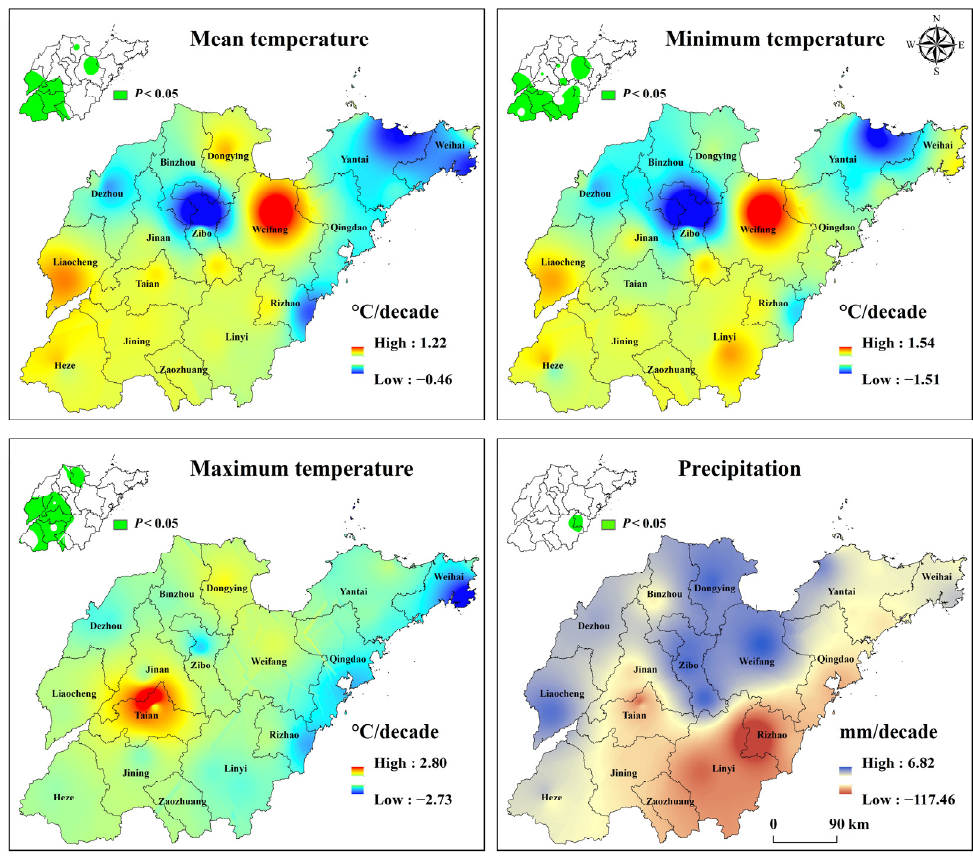
Figure 8. Change trends of mean, minimum, maximum temperature and precipitation during winter wheat seasons from 2003 to 2019 in Shandong Province. The inset at the upper left indicates the pixels with significant trends.